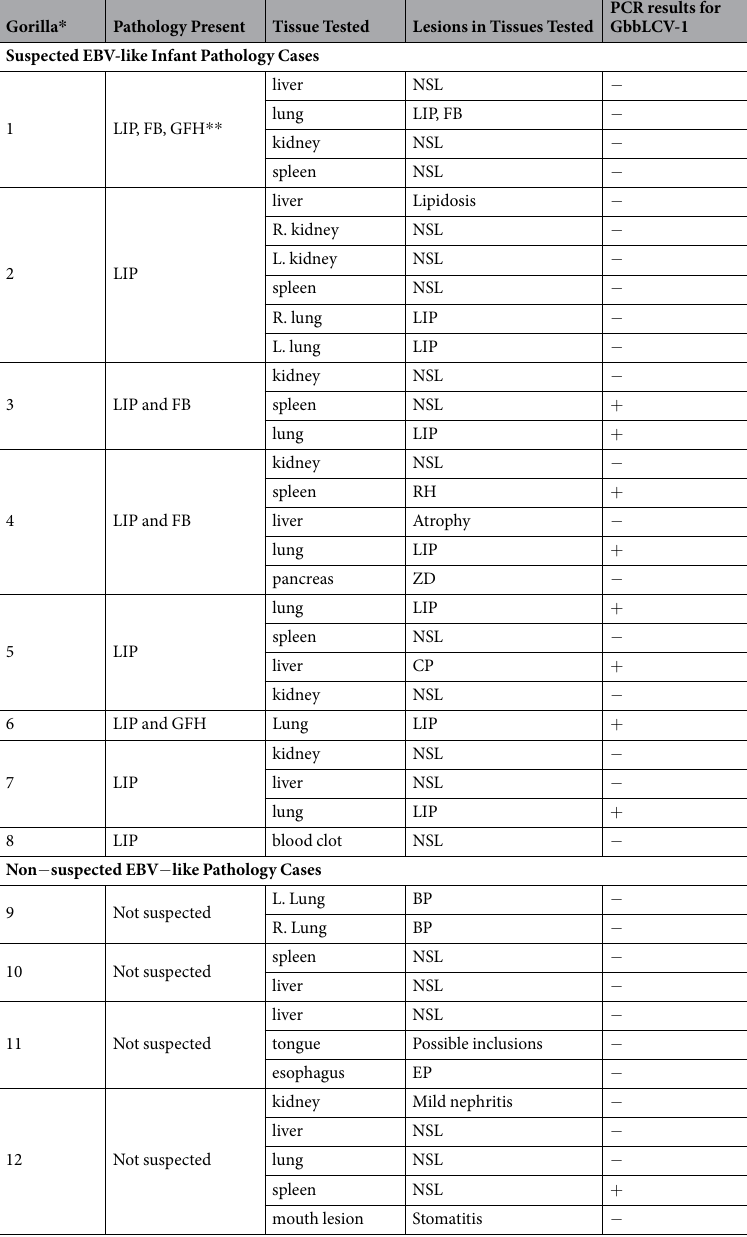
Table 2. Mountain gorilla-specific lymphocryptovirus 1 (GbbLCV-1) infection and lesions detected in post- mortem tissue samples from wild infant mountain gorillas ( Gorilla beringei beringei ) in the Virunga Massif with and without pulmonary reactive lymphoid hyperplasia. * Gorilla #1 = Bukima’s infant, #2 = Tayina’s infant, #3 = Bishushwe’s infant, #4 = Iradua, #5 = un-named infant, #6 = Mutesi, #7 = Faida’s